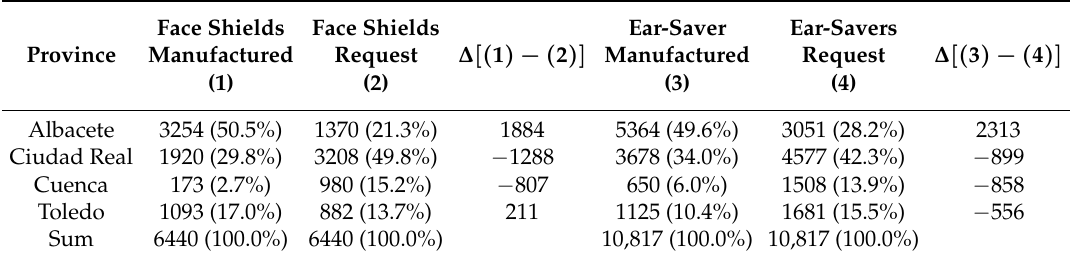
Table 6. Production and requesting of face shields and ear-savers per province in the decentralized distribution